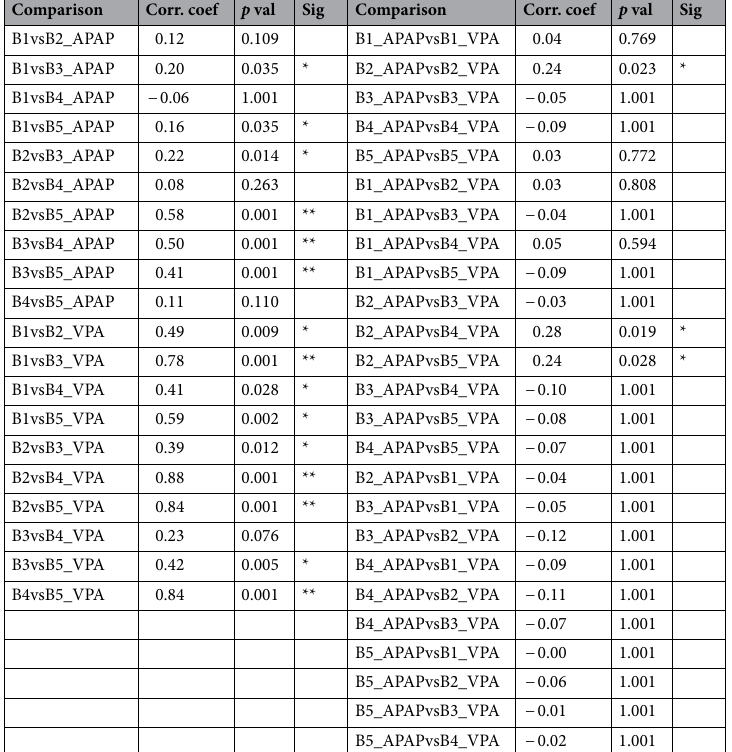
Table 2. Pearson linear correlation coefficient and p value from Mantel’s test obtained from paired comparisons of pathway analysis results. Pathway analyses were obtained comparing APAP or VPA versus CA in each batch. Correlation was performed comparing pathway analysis results from the same (APAP or VPA; left side) or different (APAP vs VPA; right side) treatments. One asterisk indicates p value < 0.05, two asterisks indicates p value <